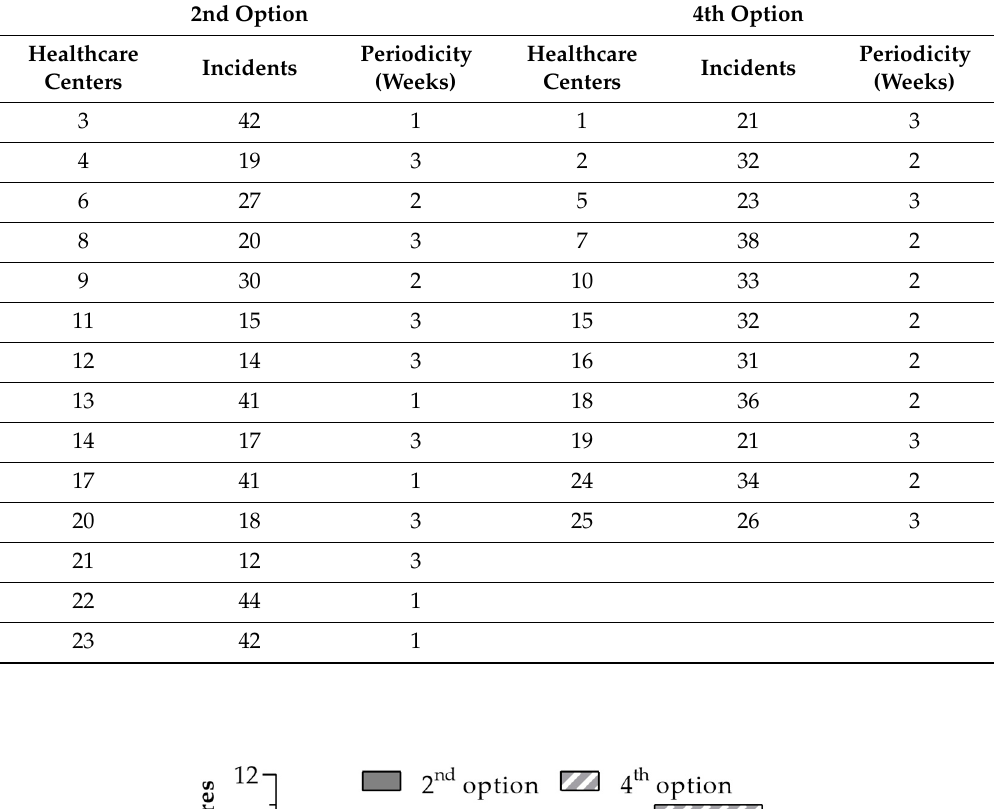
Table 5. Classification of healthcare centers.